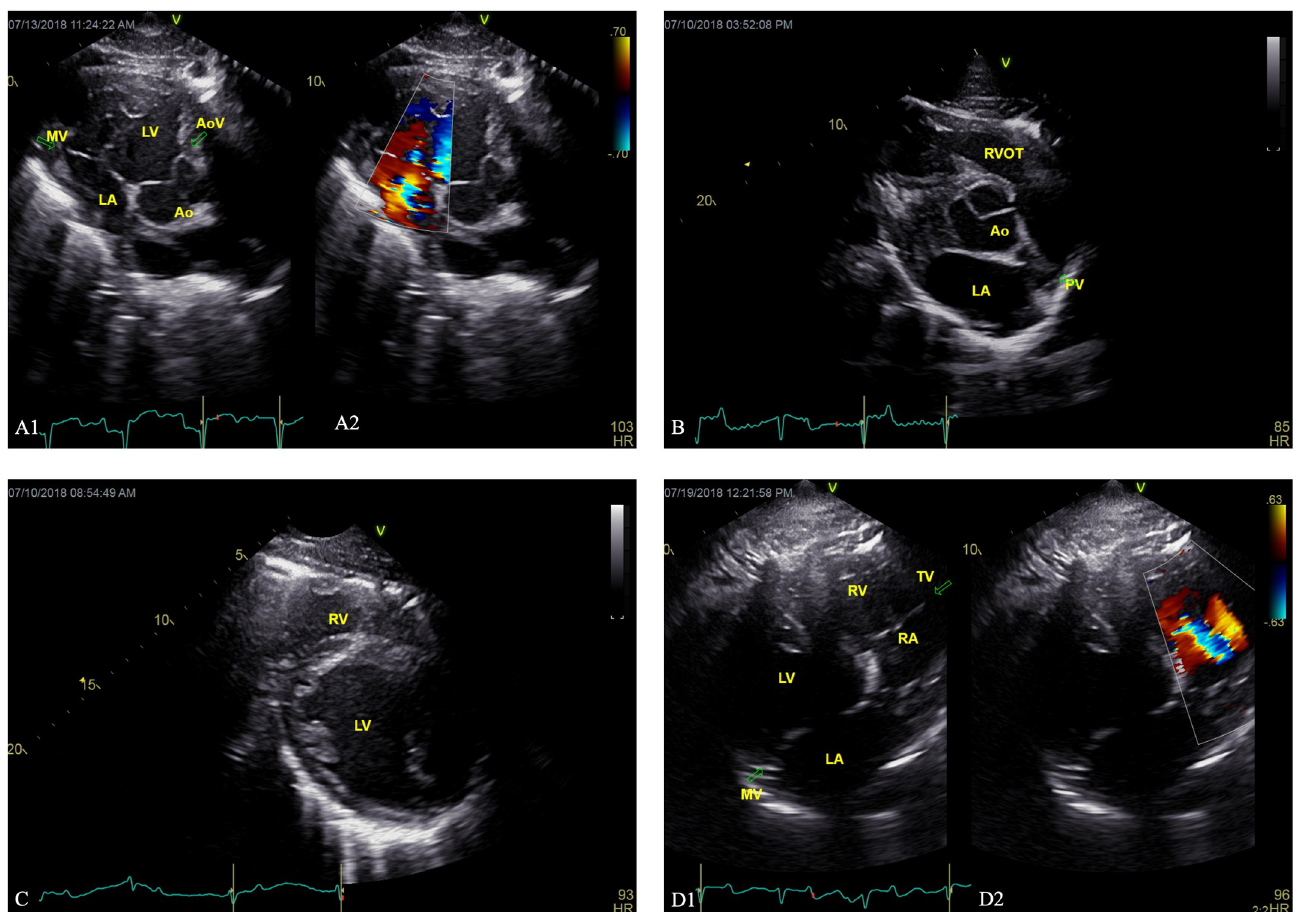
Fig 3. Echocardiogram images from BB dolphins. (A1) Two-dimensional right parasternal short axis view of the mitral valve and (A2) color Doppler showing medium mitral regurgitation in a BB dolphin. (B) Two-dimensional right parasternal short axis view of the left atrium and aorta in a BB dolphin. (C) Two- dimensional right parasternal short axis view of the left ventricle of a BB dolphin with thin left ventricular walls. (D1) Two-dimensional right parasternal short axis view of the tricuspid valve and (D2) color Doppler showing mild tricuspid regurgitation in a BB dolphin. Labels: MV = mitral valve, LV = left ventricle, LA = left atrium, Ao = aorta, AoV = aortic valve, RVOT = right ventricular outflow tract, PV = pulmonic valve, RV = right ventricle, MV = mitral valve, RA = right atrium, TV = tricuspid valve.